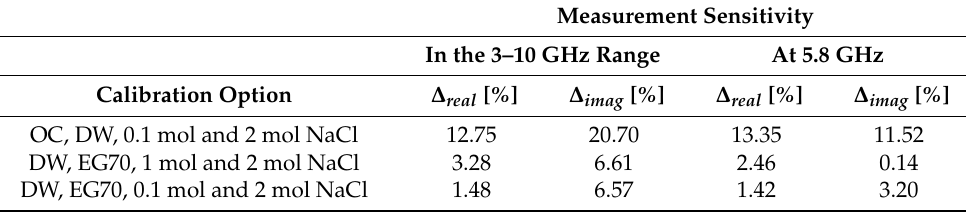
de-embedding with different calibration options.